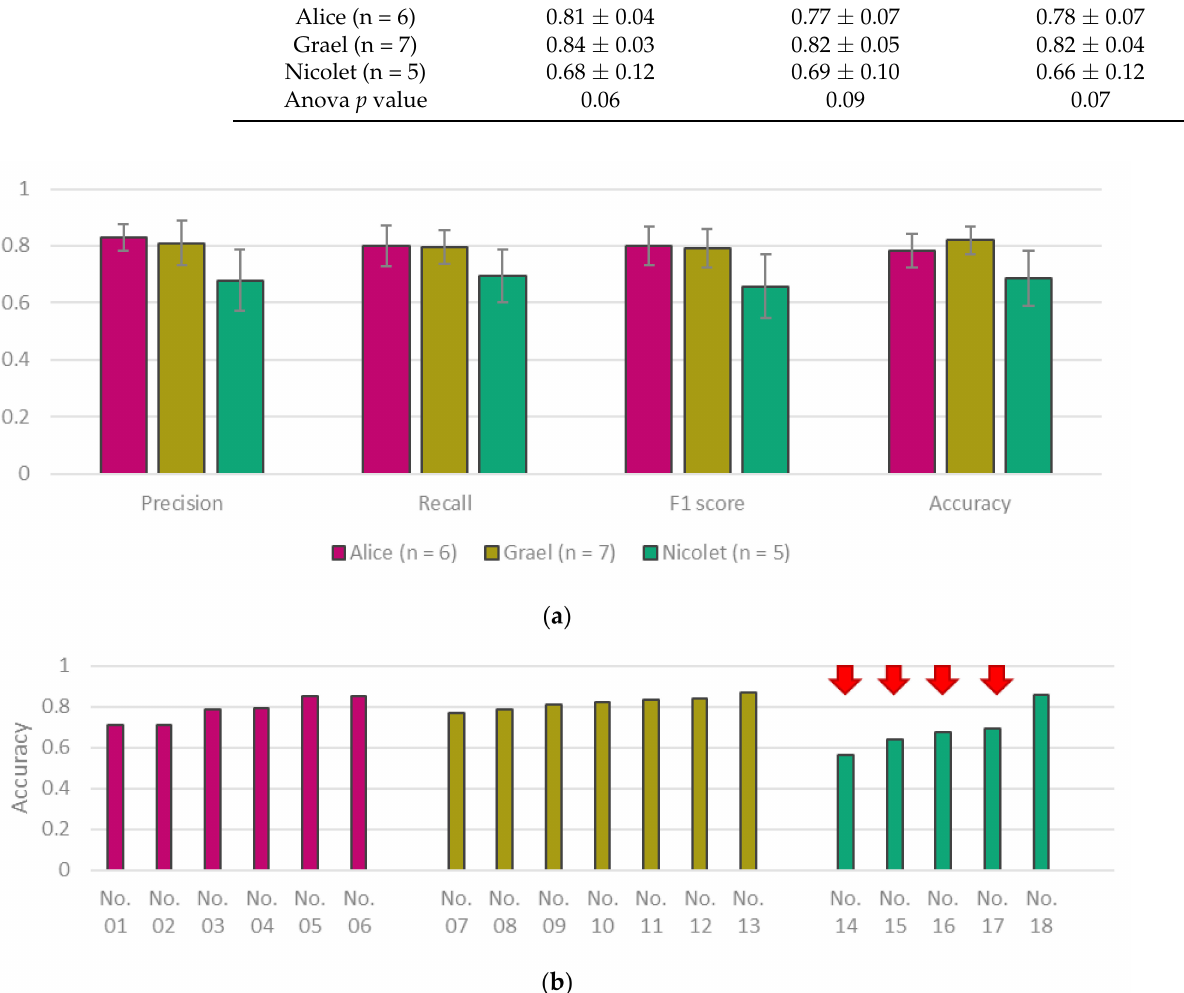
Table 5. Classification metrics of different groups in Reference dataset. Precision